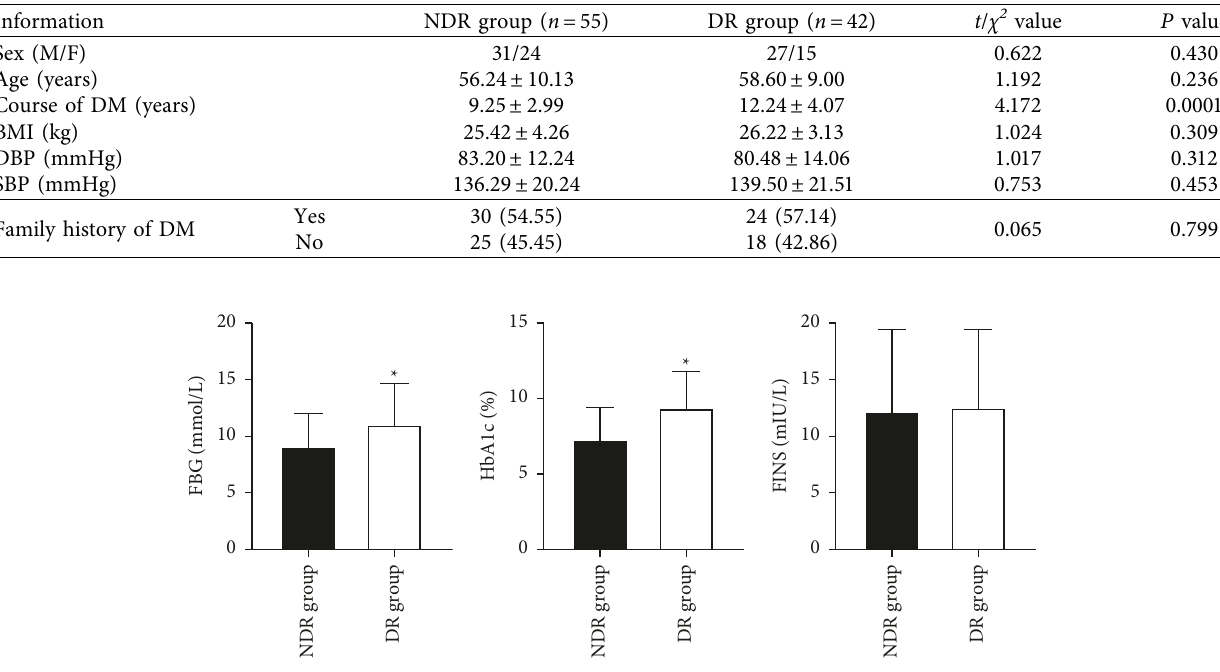
Table 1: Comparison of general information between the two groups ( x